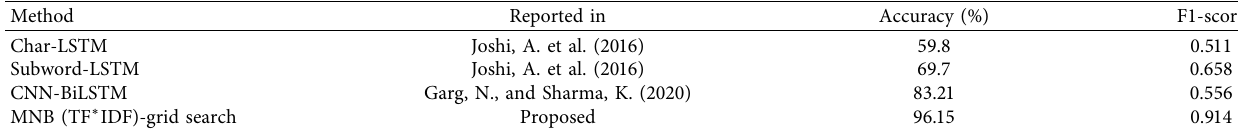
Table 4: Comparison between existing models and proposed model.